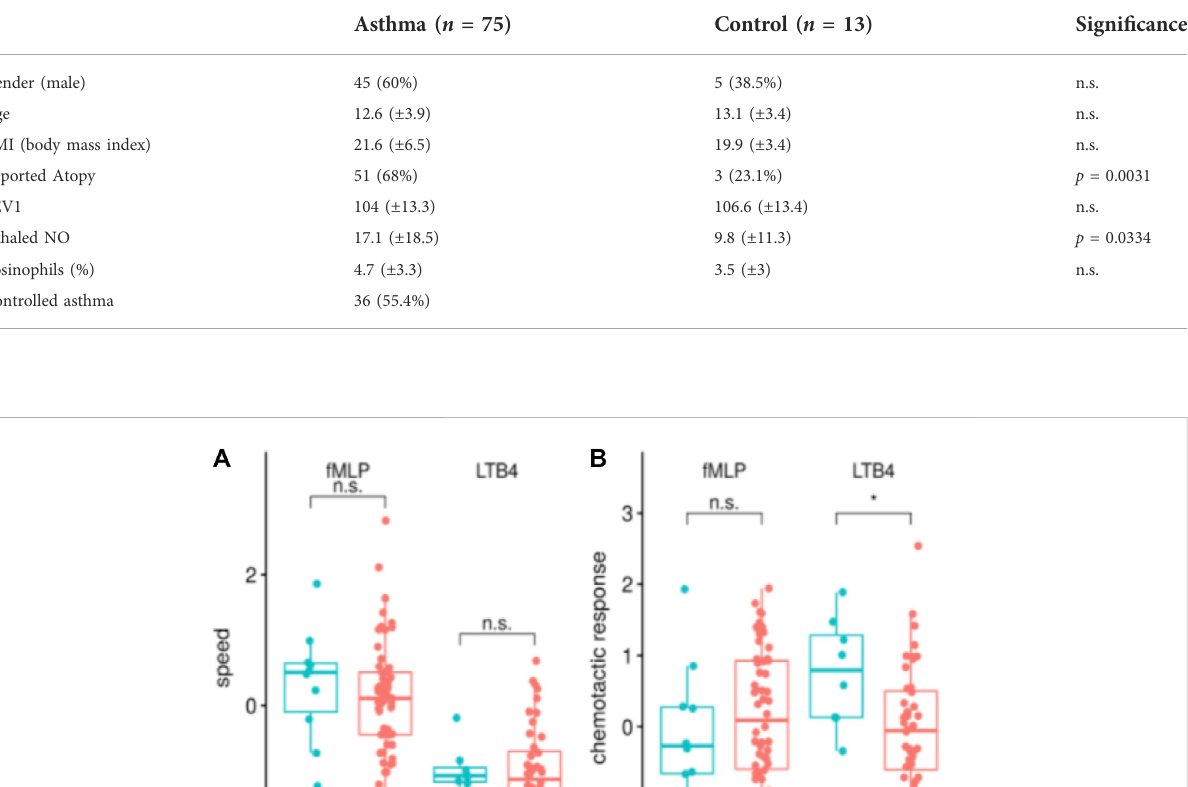
TABLE 1 The asthmatic and healthy donor populations are very similar with no signi fi cant differences in demographic parameters, but asthma patients show a signi fi cantly increased exhaled NO and reported atopy ( p < 0.05).